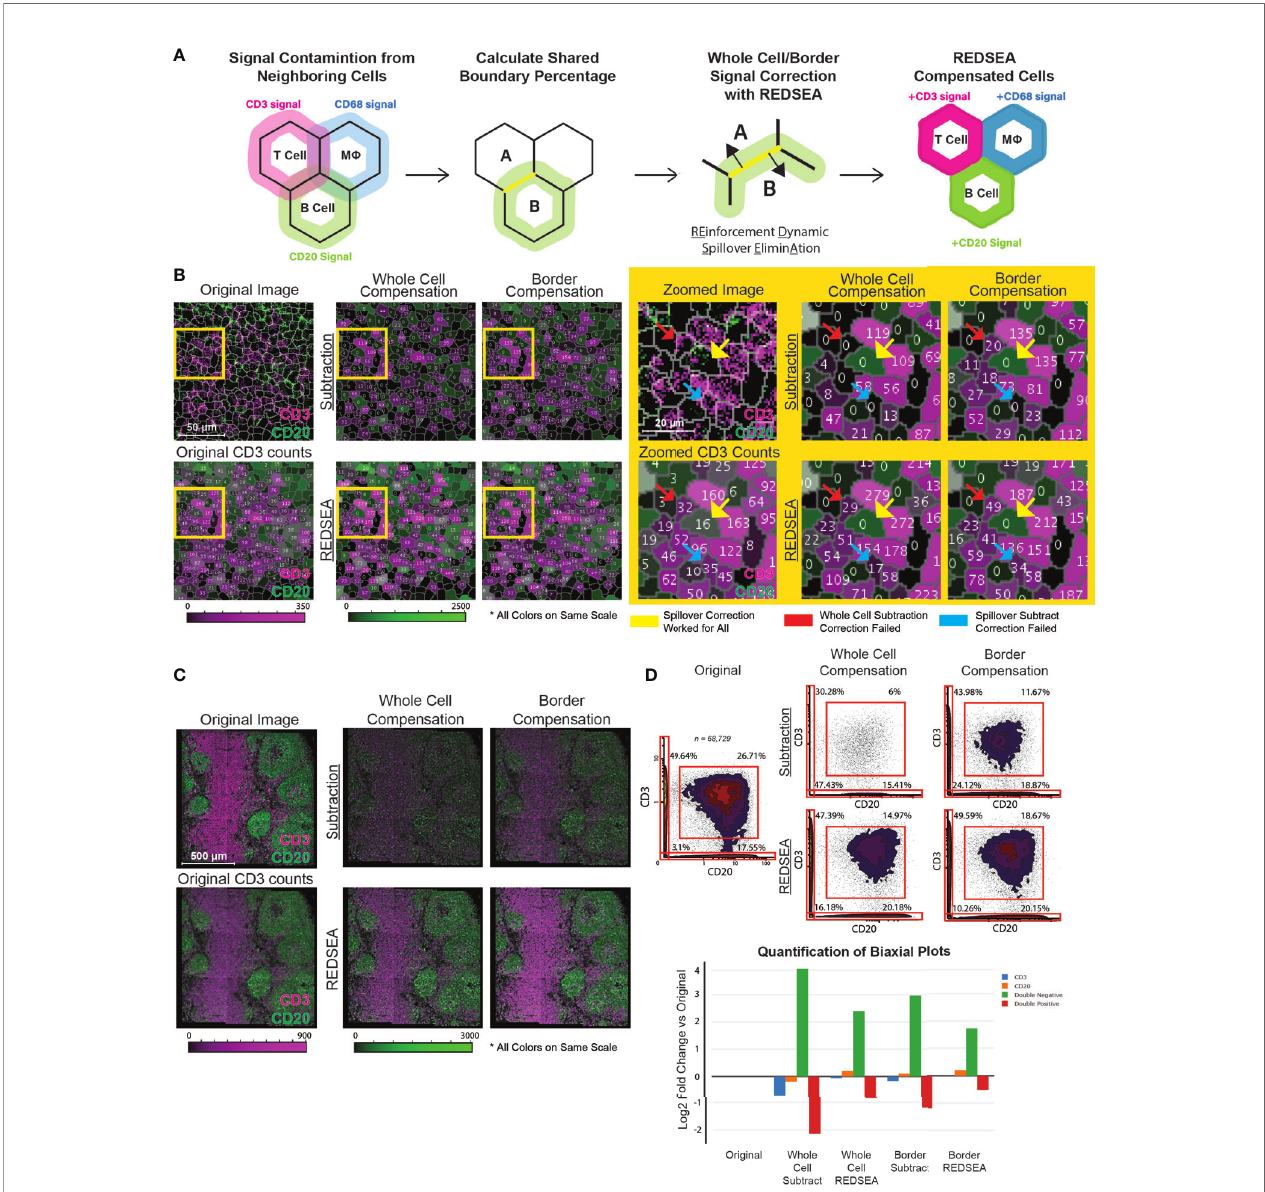
FIGURE 1 | REDSEA Corrects Signal Spillover between Adjacent Cells. (A) A schematic representing the work fl ow and principles of REDSEA compensation. The spillover signal from neighboring cells is dynamically eliminated based on the fraction of the shared boundary between neighboring cells and the signal intensity. (B) Left: A representative 150 µm x 150 µm MIBI image of a rhesus macaque lymph node. Two mutually exclusive markers are shown (CD3, magenta; CD20, green), and the numerical counts of CD3 are indicated in each segmented cell before and after images were subjected to spillover subtraction using the following four methods: 1) spillover subtraction on the whole cell, 2) spillover subtraction on only the border region, 3) REDSEA compensation on the whole cell and 4) REDSEA only on the border regions. The CD3 and CD20 counts per cell are colored on the same scale for the segmented cells across compensation settings. Right: Zoomed images of the yellow boxed regions on the left. The yellow arrows indicate representative cells for which CD3 spillover was successfully corrected by all the four methods; red arrows indicate successful correction by all but the whole cell subtraction method, and blue arrows indicated successful correction only by REDSEA- based and not the other compensation methods. (C) A representative 1200 µm x 1200 µm MIBI image of a rhesus macaque lymph node subjected to spillover corrections as indicated above in (B) . (D) Top: Biaxial plots of marker intensities of 68,739 single cells from segmented MIBI images of rhesus macaque lymph nodes. The percentage of single-positive (top left and bottom right quadrants), double-positive (top right quadrant), and double-negative (bottom left quadrant) cells are shown for each compensation method. Bottom: A log2 fold change plot (compensated over original non-compensated) for single-positive, double-positive, and double-negative gated